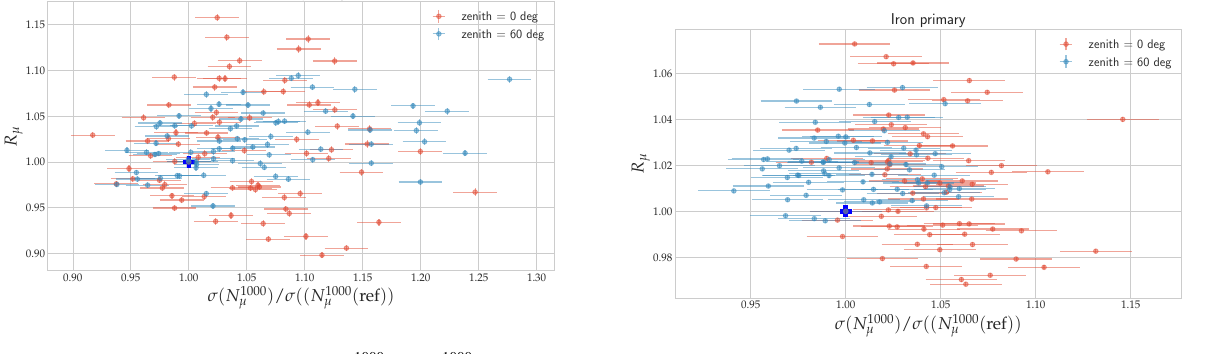
Figure 8. Results of simulations in [ σ ( N 1000 iron